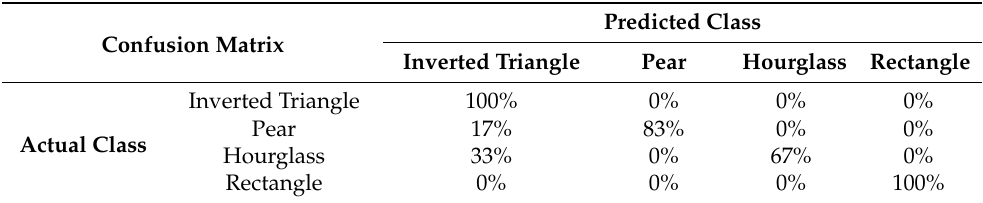
Table 2. Confusion matrix for the classification of 4 body shapes using the k-NN classifier with the bag-of-features.